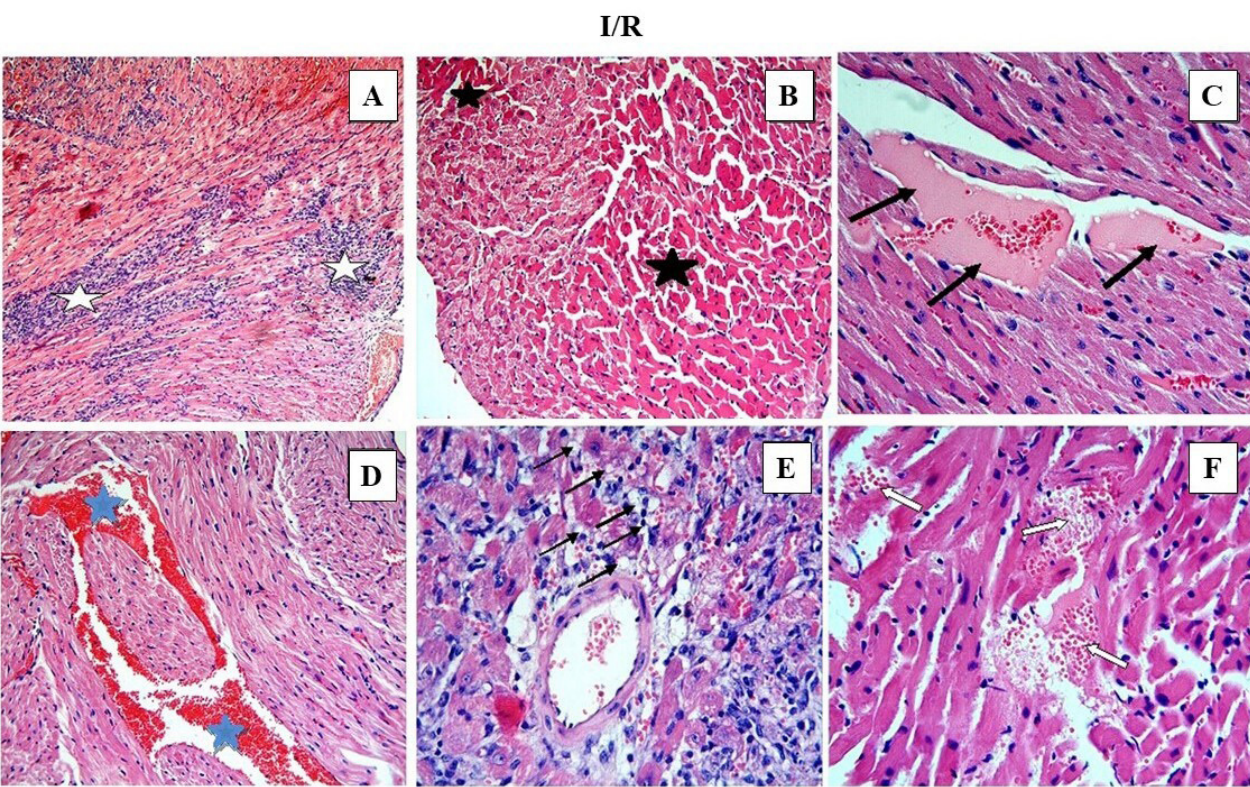
FIGURE 2 - Intense mononuclear cell infiltration (white asteriks) (A), eosinophilic stained and pyknotic nuclei cells (black asteriks) (B), necrosis (arrows) (C), vascular congestion (blue asteriks) (D), vacuolisation (thin black arrows) (E), hemorrhage (white arrows) (F) observed in the I/R group. A:H-E; X10, B, D:H-E; X20, C, E, F: H-E;